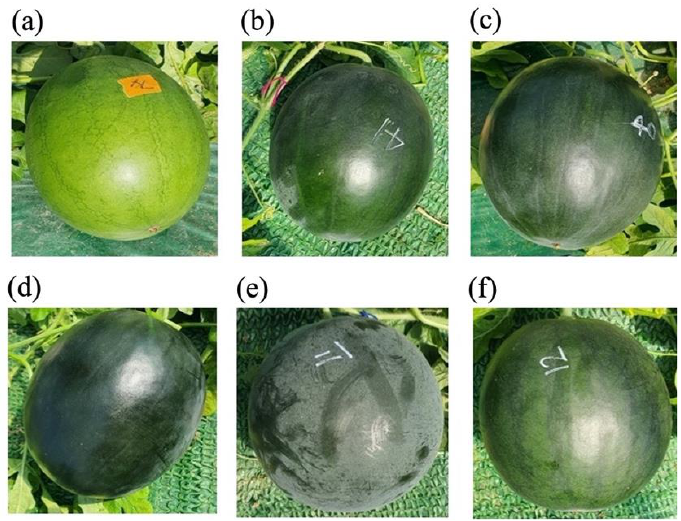
Figure 1. Watermelon fruit images of six F 2 plants showing variations in the rind color (RC) and bloom formation (BF). ( a ) Light green rind (LG); ( b , c ) intermediate dark green rind (IDG); ( d ) dark green rind (DG); ( e ) bloom (B), and ( f ) bloomless (BL). The bloom was evident in ‘ SIT55616RN ’ and F 1 , showing complete dominance. In F 2 ,